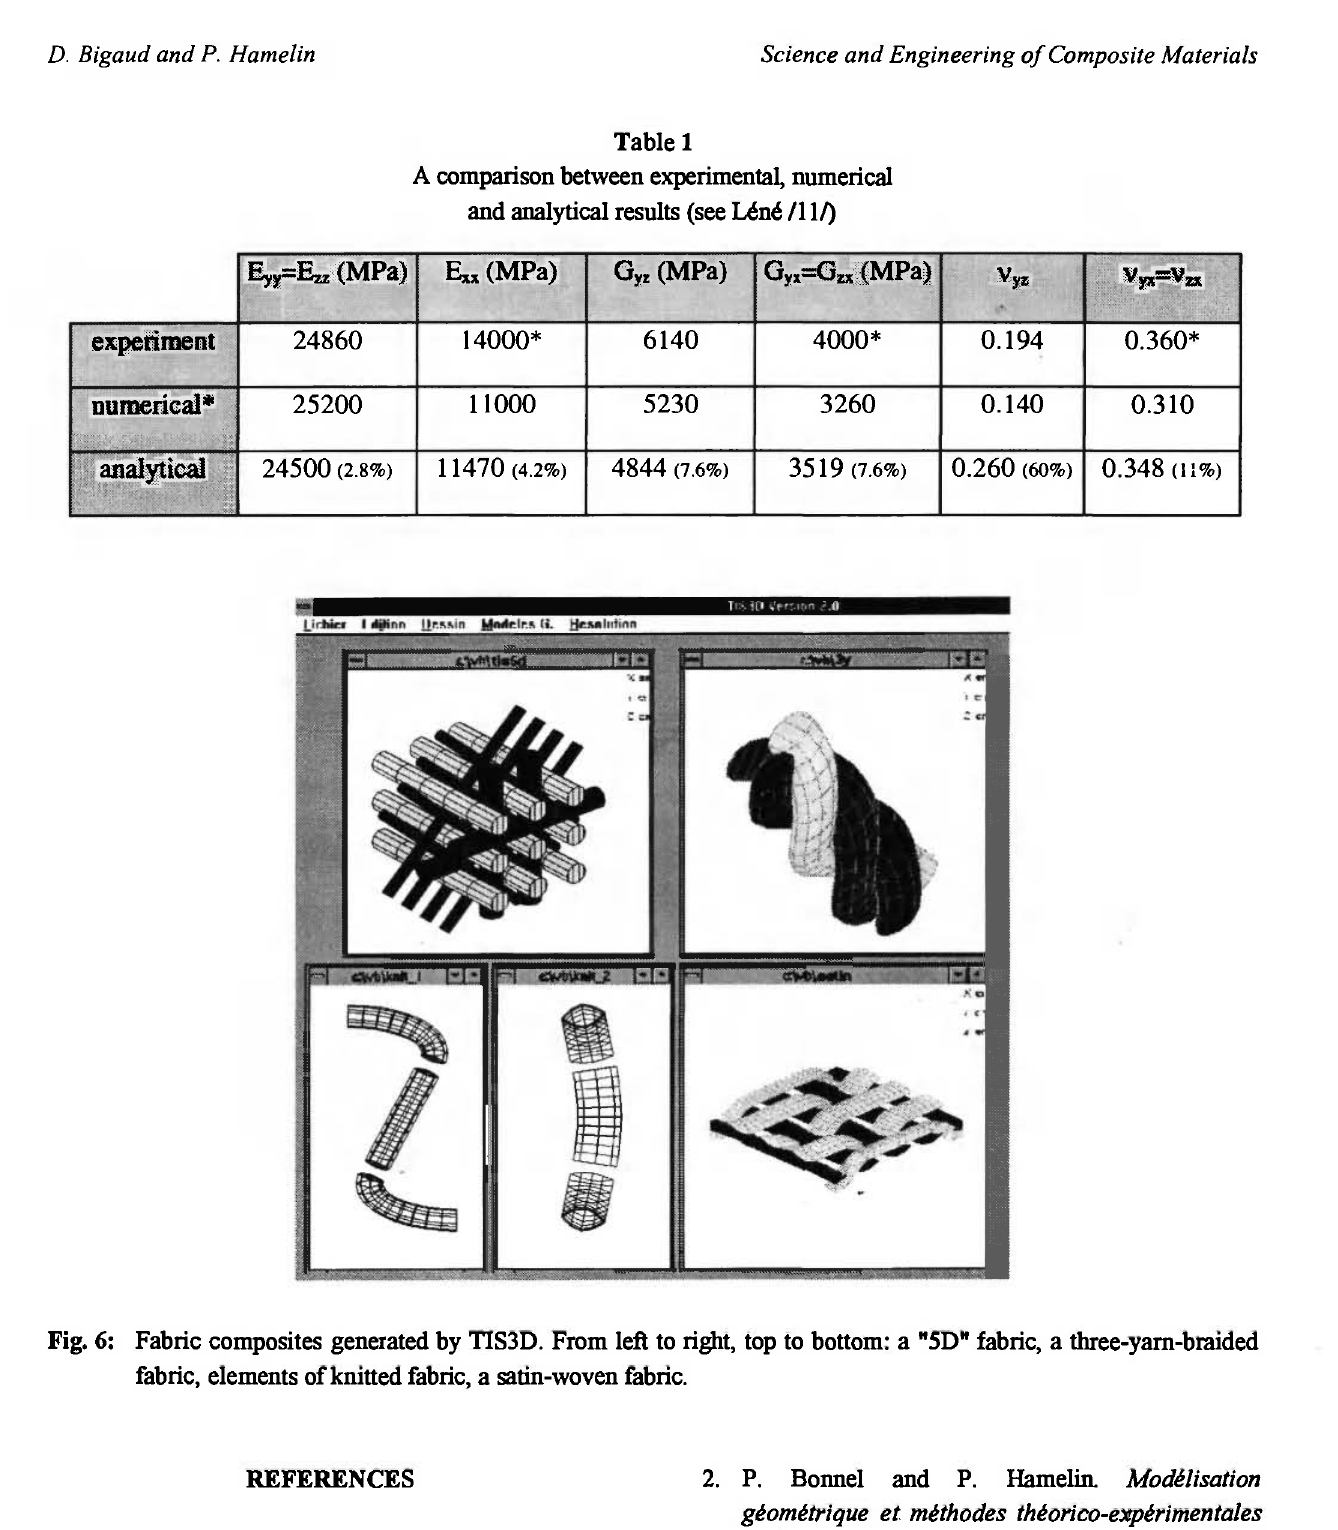
A comparison between experimental, numerical